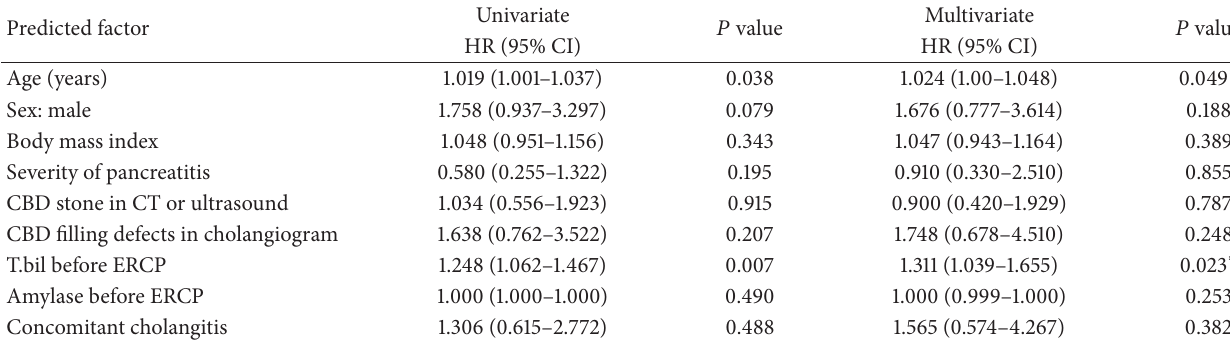
Table 3: Predictive factors of gross stone retrieved from common bile